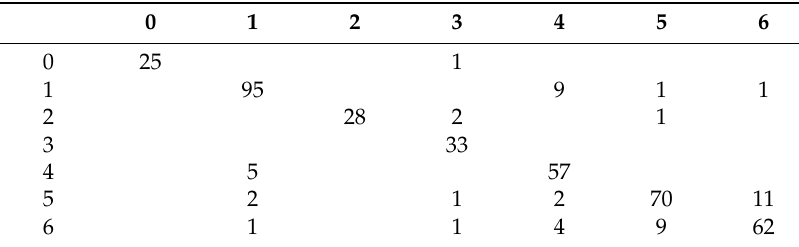
Table A5. The confusion matrix of Figure 12a.